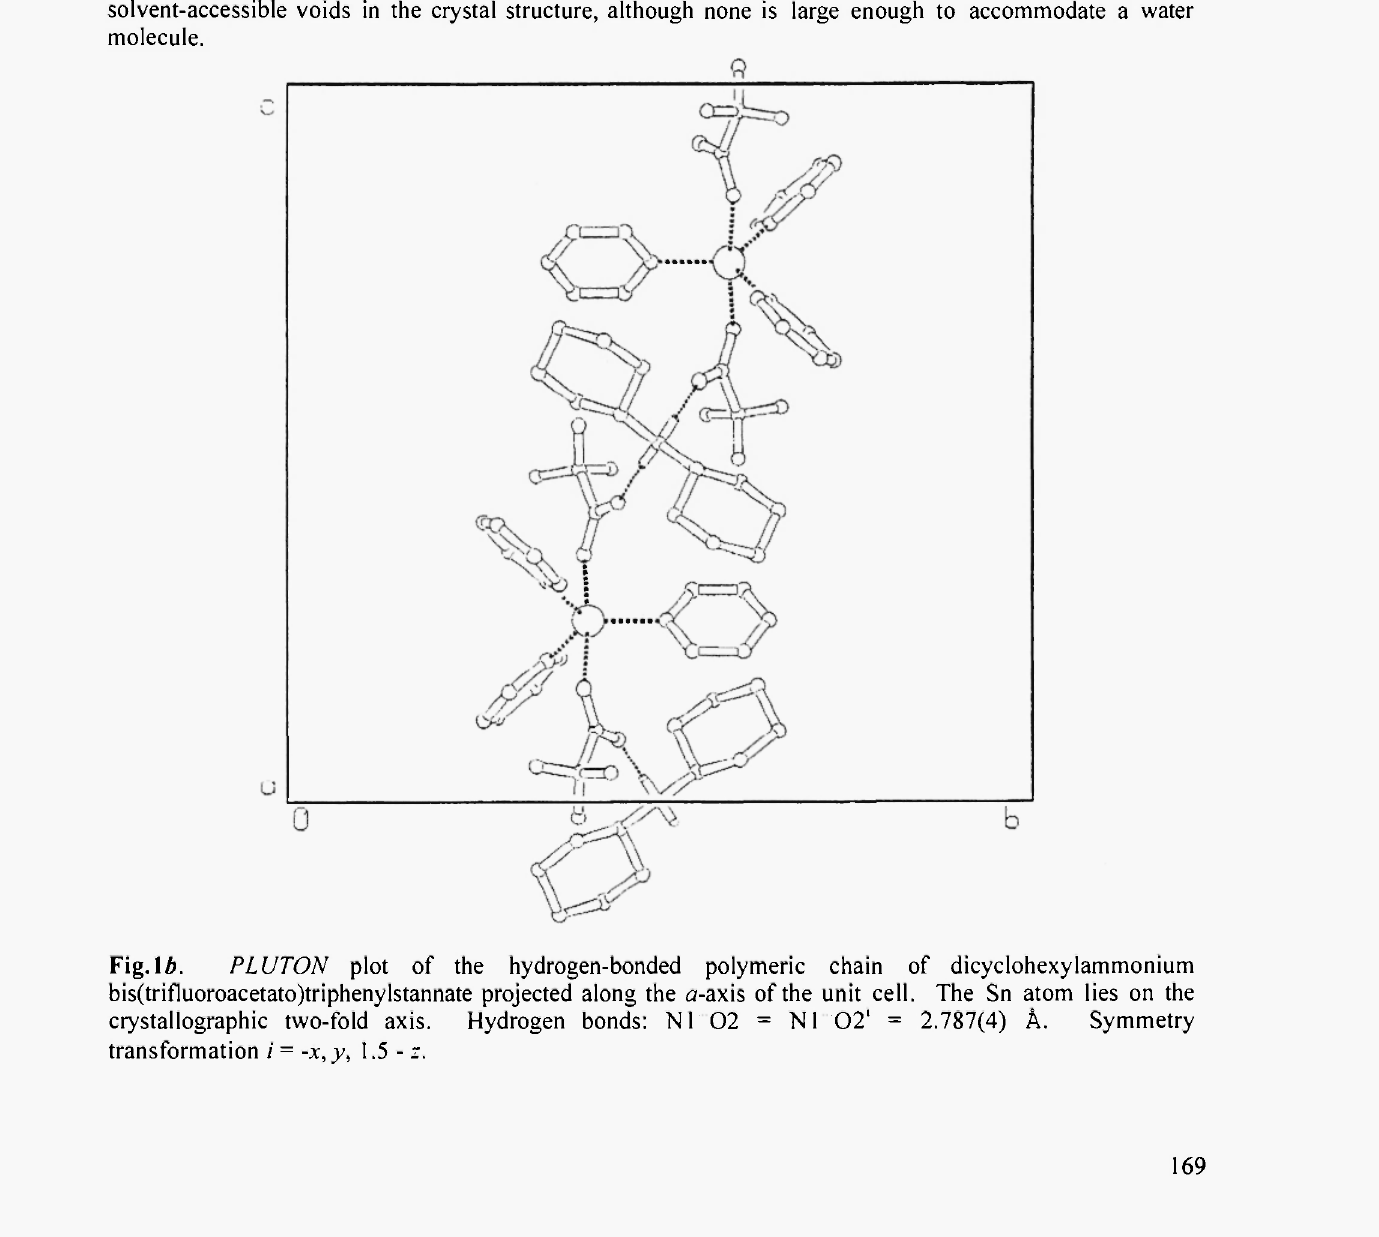
Fig. 1A. PLUTON plot of the hydrogen-bonded polymeric chain of dicyclohexylammonium bis(trifluoroacetato)triphenylstannate projected along the α-axis of the unit cell. The Sn atom lies on the crystallographic two-fold axis. Hydrogen bonds: Ν1 02 = Ν1 02' = 2.787(4) A. Symmetry transformation / = -χ, y, 1.5-